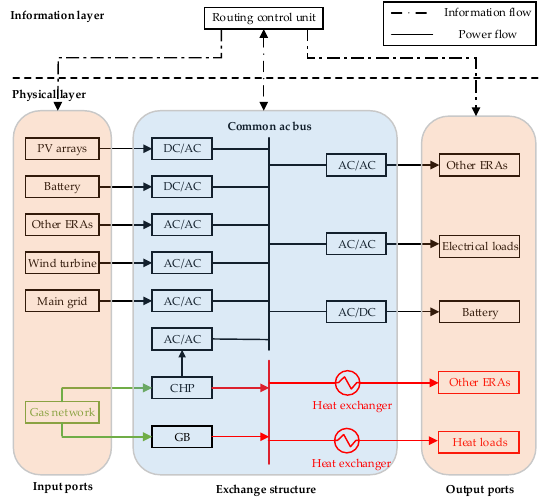
Figure 2. A basic structure of an energy routing center (ERC).